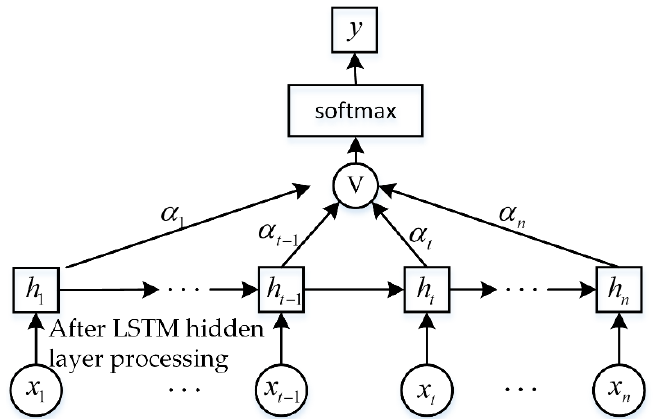
Figure 4. Structure of attention mechanism.